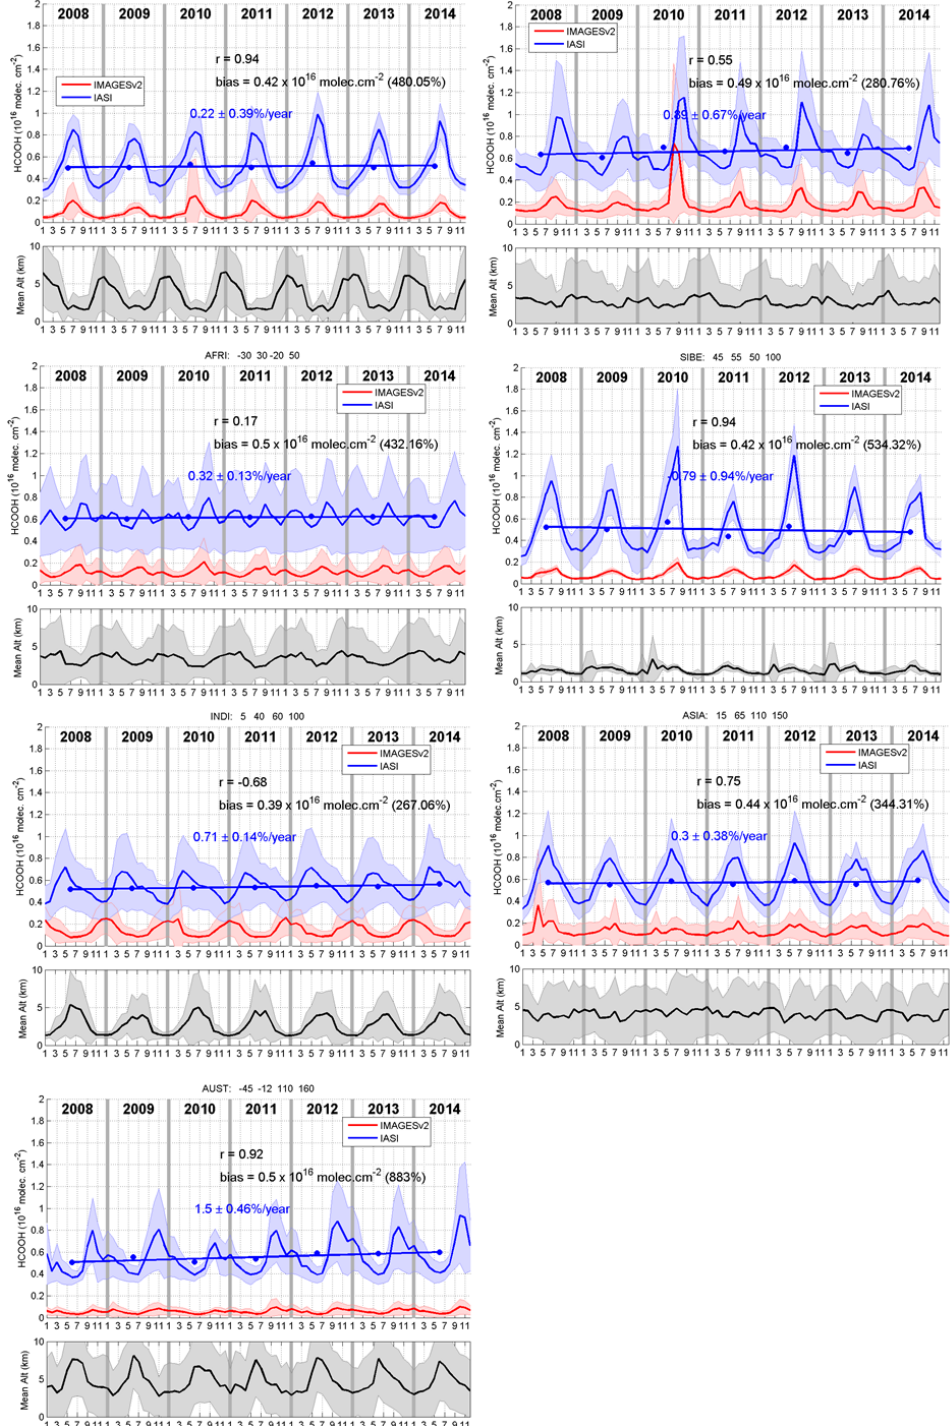
Figure 13. Time series of the monthly HCOOH column means for IASI (blue) and IMAGESv2 (red) over different regions highlighted by black boxes in Fig. 1, between 2008 and 2014. The coordinates of each box (latitude and longitude) are written on the top of each plot. The red and blue shaded areas correspond to the monthly standard deviation. The correlation coefficient, the mean bias, and the normalized mean bias (in parentheses) for the full period are given on each plot. The blue dots correspond to the annual IASI mean. The linear regression on the annual IASI mean and the calculated linear trend are also provided. On the bottom panel, the mean altitude of the maximum in the HCOOH vertical distribution from IMAGESv2 is plotted in black with the corresponding standard deviation represented by the black shade